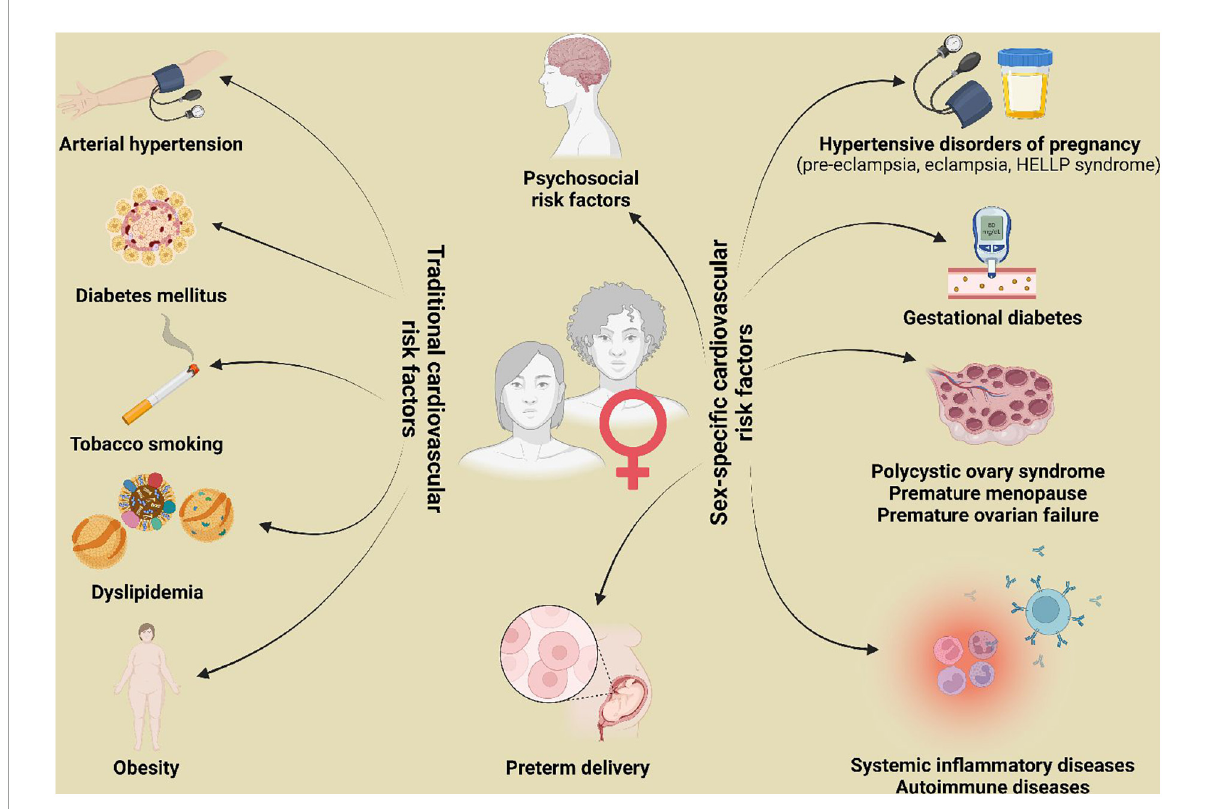
FIGURE2 Traditional and sex-specific cardiovascular risk factors. HELLP, hemolysis, elevated liver enzymes and low